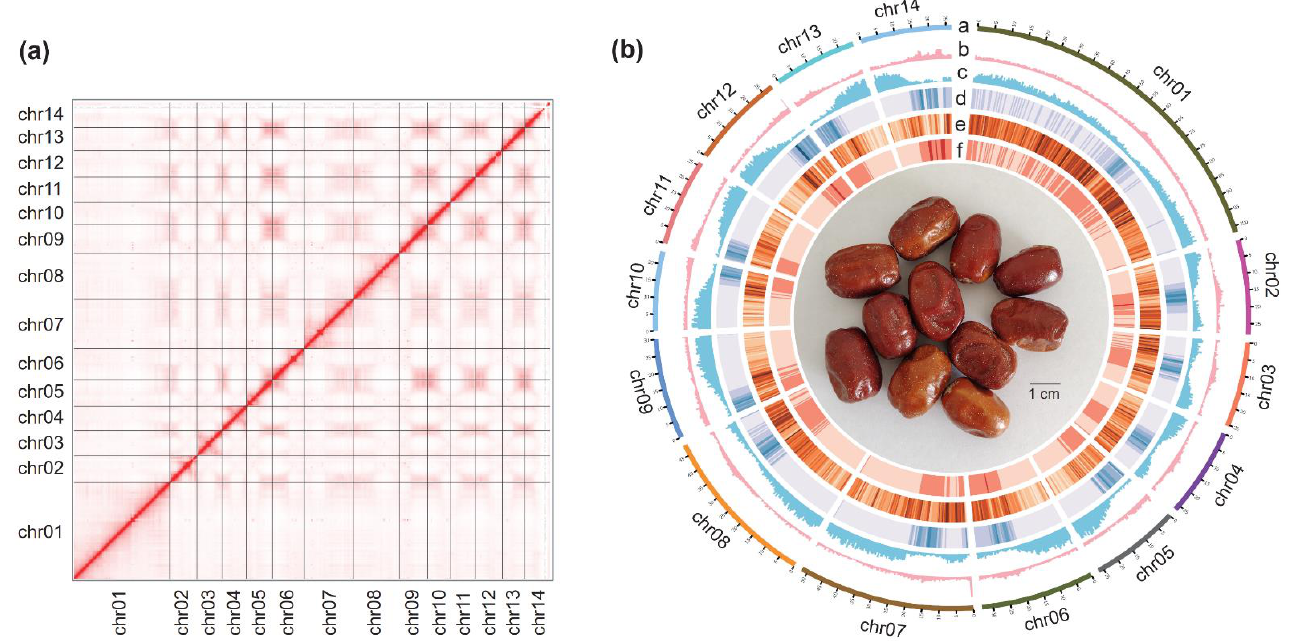
Figure 1. The genome features of E. moorcroftii . ( a ) Heatmap of Hi-C interactions for 14 pseudochro- mosomes. ( b ) Circos plot showing the genomic landscape of E. moorcroftii . The tracks from outer to inner circles indicate the following: a: 4 pseudochromosomes in megabases; b: GC content; c: gene density; d: density of Gypsy LTR retrotransposons; e: density of Copia LTR retrotransposons; f: LTR retrotransposons density. The center of the circos plot shows the fruits of E. moorcroftii (photo by